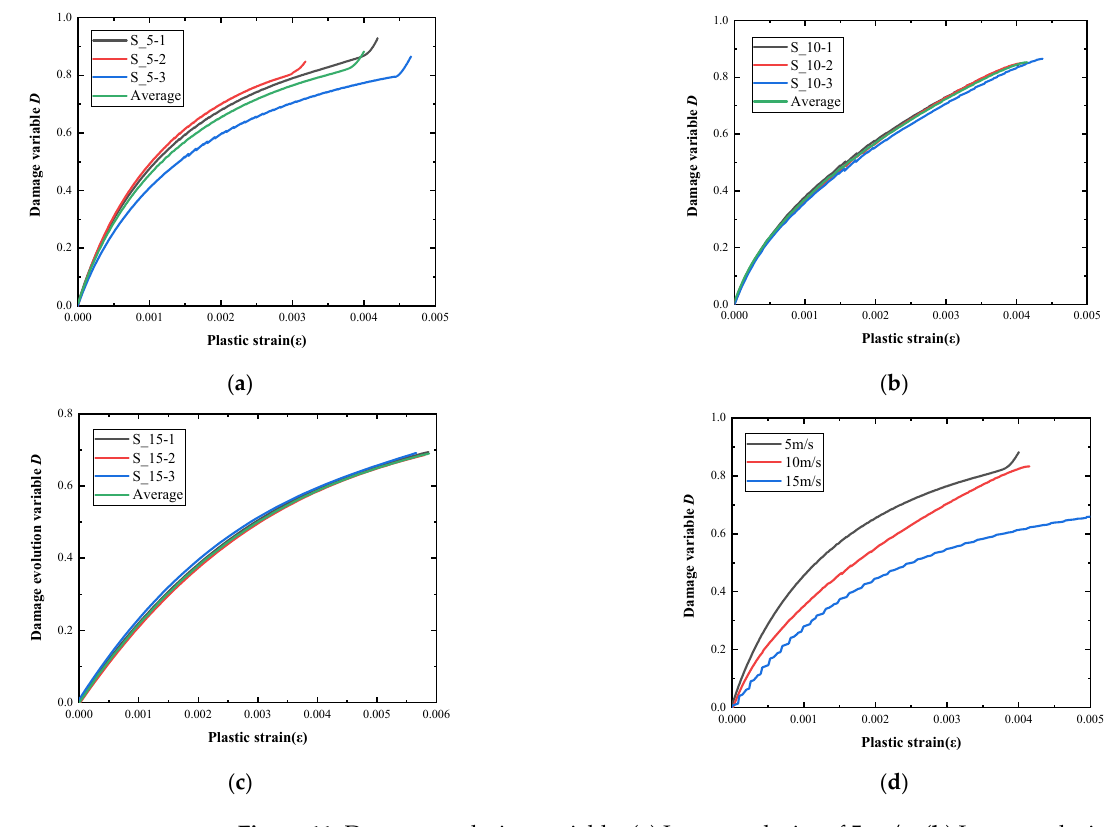
Figure 11. Damage evolution variable. ( a ) Impact velocity of 5 m/s. ( b ) Impact velocity of 10 m/s. ( c ) Impact velocity of 15 m/s. ( d ) Average value.